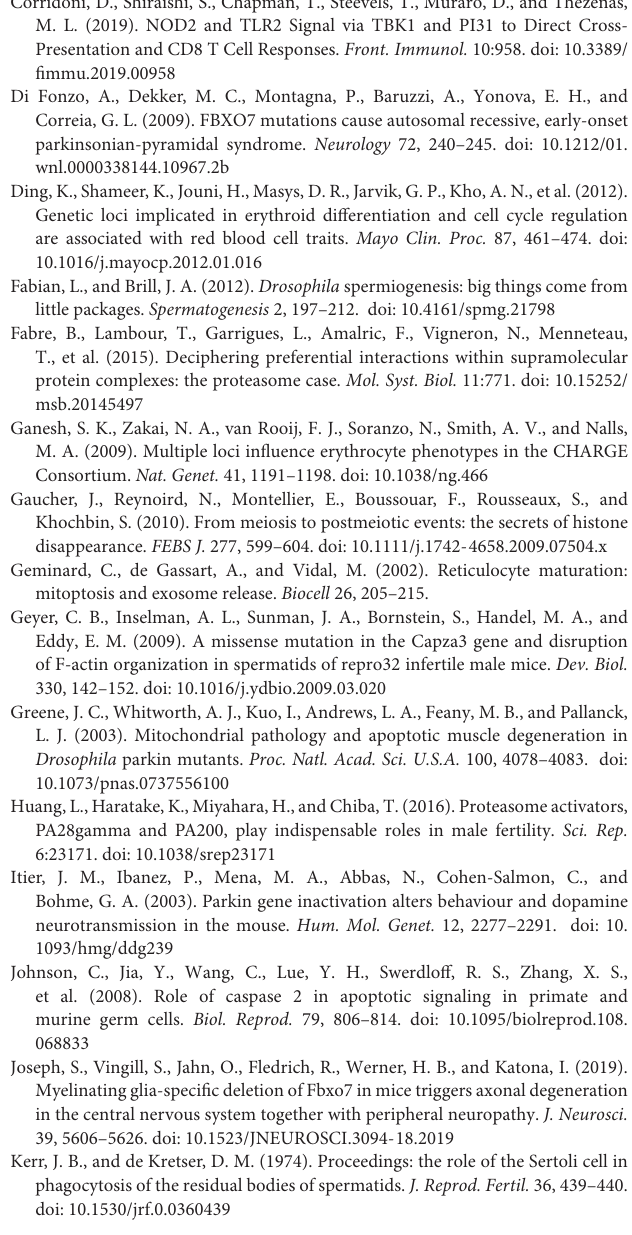
FIGURE S3 | (A) Immunoblotting using the antibody against human Fbxo7 (made in house) of duplicate samples of whole cell lysates made from SHSY5Y cells stably expressing with an empty vector or a short hairpin RNA targeting Fbxo7 expression. (B) Immunoblotting of samples of whole cell lysates made from U2OS cells stably expressing with an empty vector or three independent short hairpin RNAs targeting PI31 expression. (C) Representative examples of negative control immunohistochemical staining on wild type and homozygous LacZ testes, omitting the various primary antibodies, relating to images shown in Figures 2G–L, 5A,B . Arrows indicate mis-localised spermatid nuclei in the “graveyards.” (D) Representative examples of negative control immunohistochemical staining on wild type testes, omitting the PI31 primary antibody, relating to images shown in Figure 6 . There was no specific germ cell staining, only residual auto-fluorescence in interstitial tissue between the